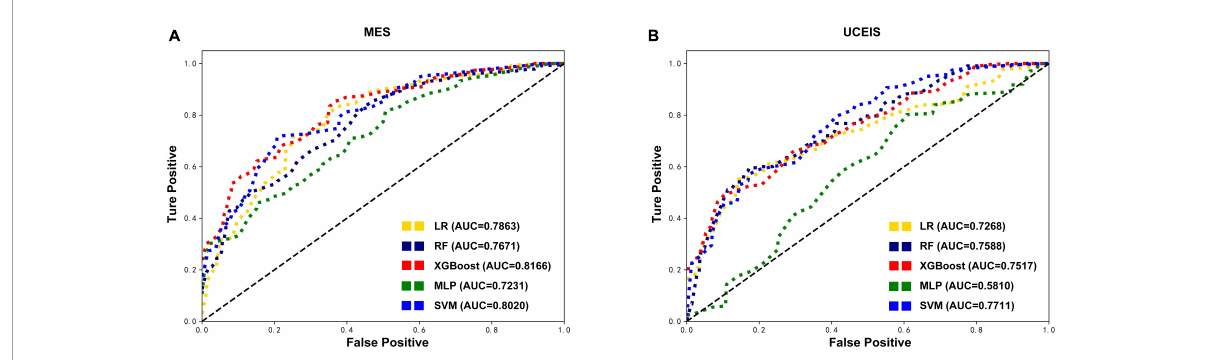
FIGURE2 Comparison of the original test datasets-based models’ performance. Receiver operating characteristic curves showing the endoscopic disease activity predictive performance of five algorithms based on the mayo endoscopic subscore (MES) (A) and ulcerative colitis endoscopic index of severity (UCEIS) (B) in test datasets. LR, logistic regression; RF, random forests; XGBoost, extreme gradient boost; MLP, multilayer perceptron; SVM, support vector machine; AUC, area under the receiver-operating characteristic